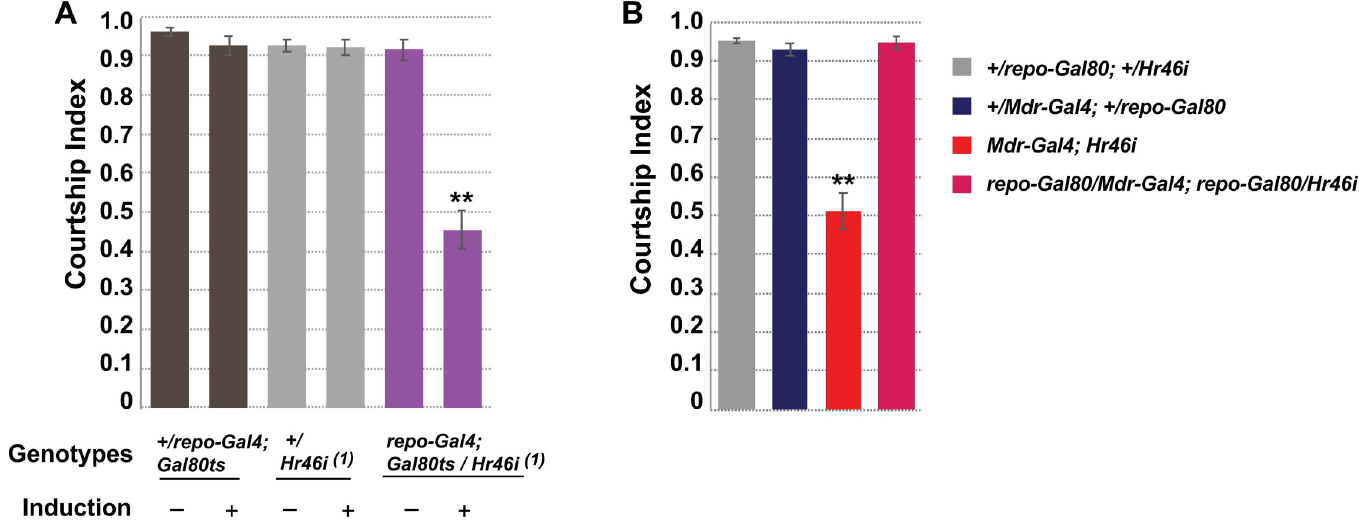
Fig 4. Hr46/Hr3 is required in the glial SPG cells for courtship. Graphs show the courtship index CI (fraction of time males spend courting during the observation period) ± SEM. N = 20. Data were analyzed by ANOVA followed by Tukey multiple comparisons (p < 0.05). Indices that are significantly different from the controls are marked by asterisks. (A) Conditional glial knockdown of Hr46/Hr3 in mature males using repo-Gal4; tubP-GAL80 ts reduces courtship. (B) The courtship reduction of Mdr-Gal4 directed Hr46/Hr3 knockdown can be reversed by Gal80 expression in glial cells by repo-Gal80 .